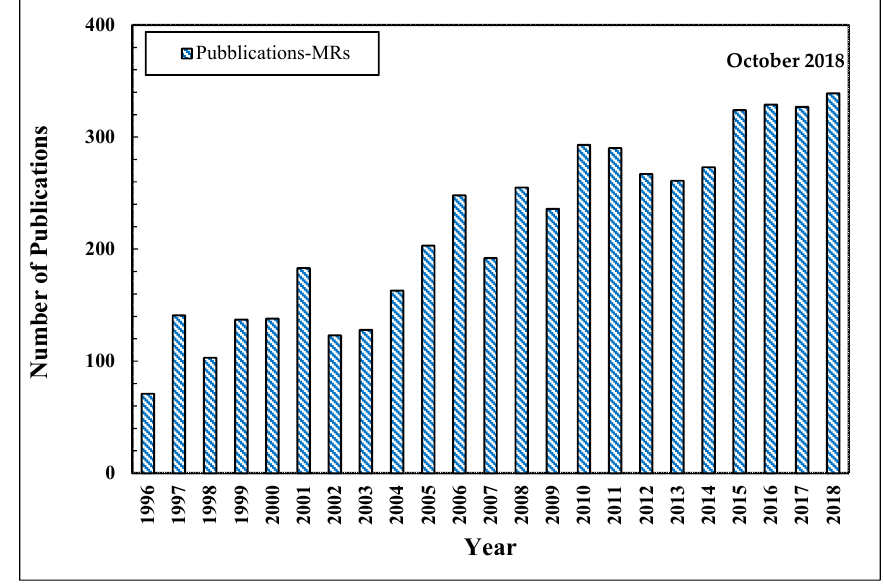
Figure 4. Number of scientific publications about the MRs vs. year. Scopus database: www.scopus.com.